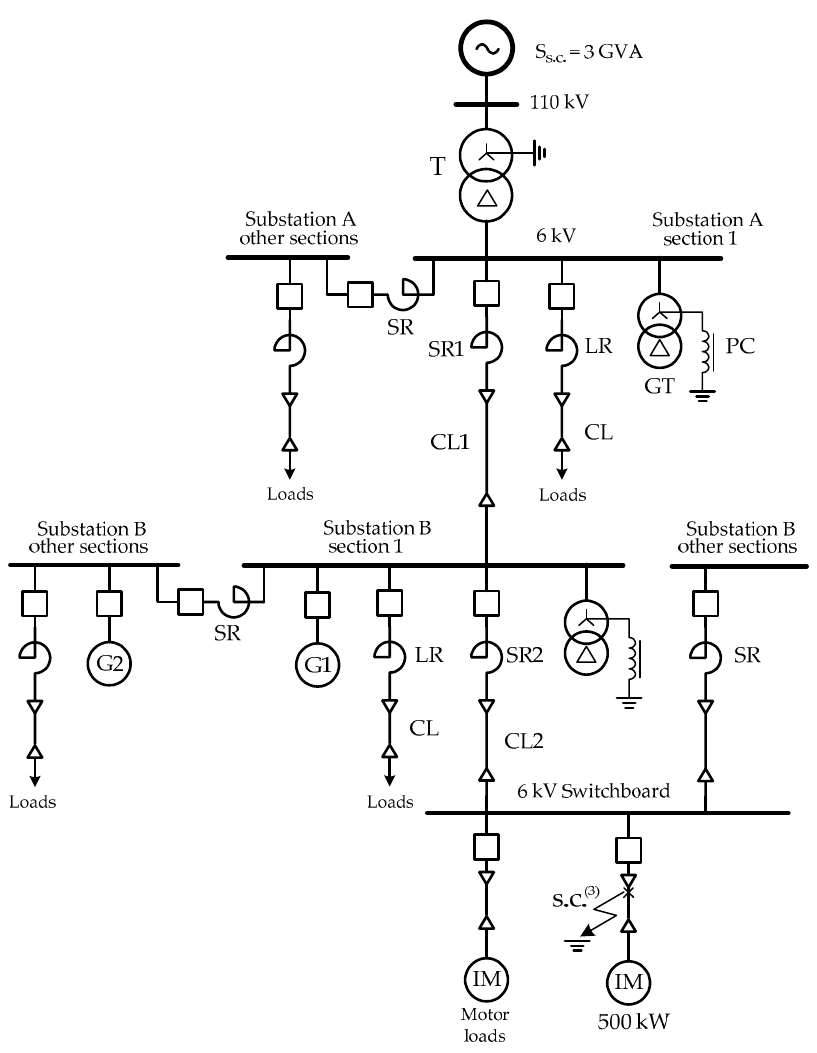
Figure 3. Single-line diagram of the industrial grid.